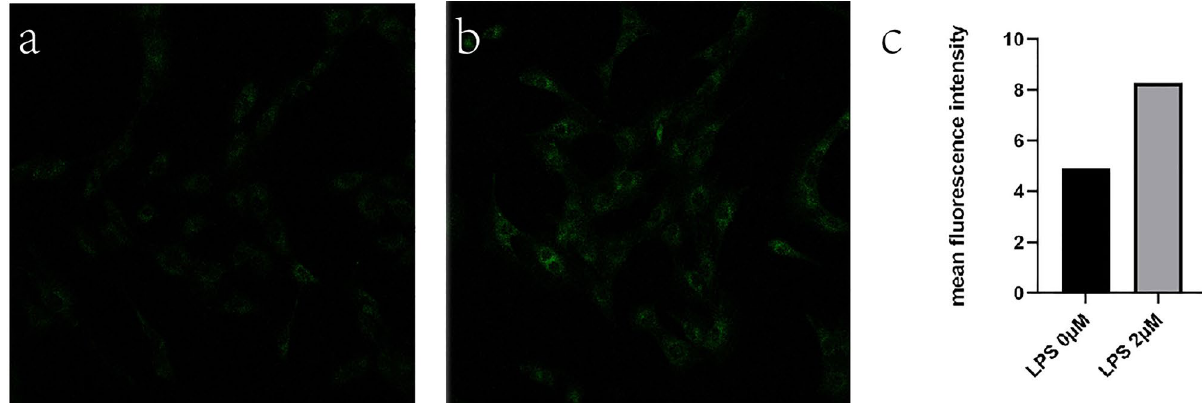
Figure 4. Cell fluorescence imaging of LPS induced endogenous H 2 S. ( a ) LPS 0 μM as control group. ( b ) Fluorescence image of MC3T3-E1 cells incubated with LPS (2 μM) for 30 min, then incubated with H 2 S probe (10 μM) for 30 min. ( c ) Fluorescence intensity